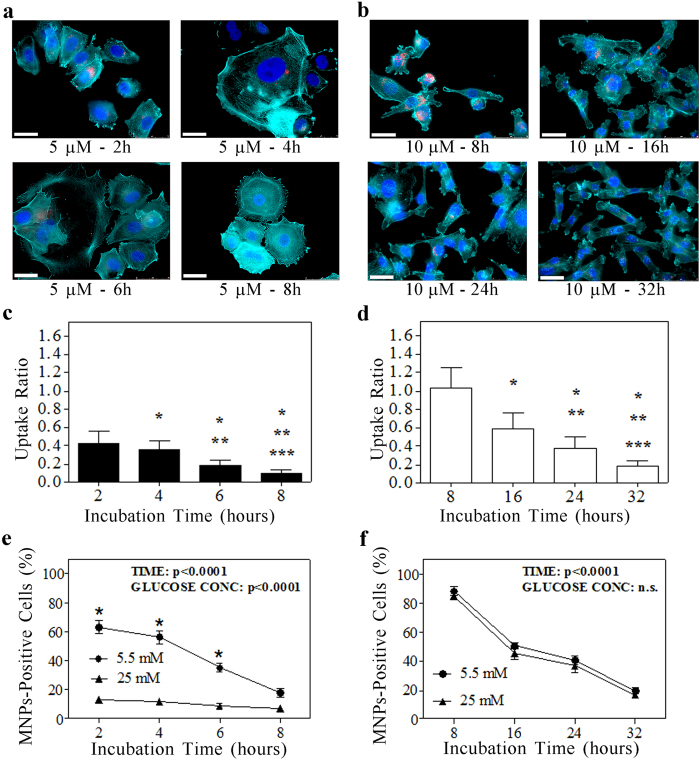
Selective inhibition of GLUT1 transporters suppresses the MNPs glucose shell effect.(a,b) representative examples of MCF7 (a) and MDA-MB-231 (b) fluorescence images after the administration of STF-31 inhibitor at different time points (glucose medium concentration: 5.5 mM). In red are evidenced the MNPs, in cyan the actin filaments and in blue the nuclei. Scale bars: 30 μm. (c,d) histograms represent the uptake ratio (mean ± standard deviation) of MCF7 (c) and MDA-MB231 (d) at different time points. *, **, ***p < 0.01 vs. the first, the second and the third column, respectively (One-way Anova followed by Bonferroni post-hoc test). (e,f) Quantification of the MNPs-uptake as fraction of cells stained by the Perls’ iron after GLUT1 inhibition in MCF7 cells (STF-31 administered at 5 μm) (e) and MDA-MB-231 cells (STF-31 administered at 10 μm) (f). About a 20% of positive cells were found in both cancer subtypes at the latter time points, probably due to unspecific uptake processes. A two-way ANOVA test was used to examine the influence of time and glucose-concentration on MNPs uptake in either MCF7 (e) or MDA-MB-231 (f). *p < 0.0001 vs. 25 mM.